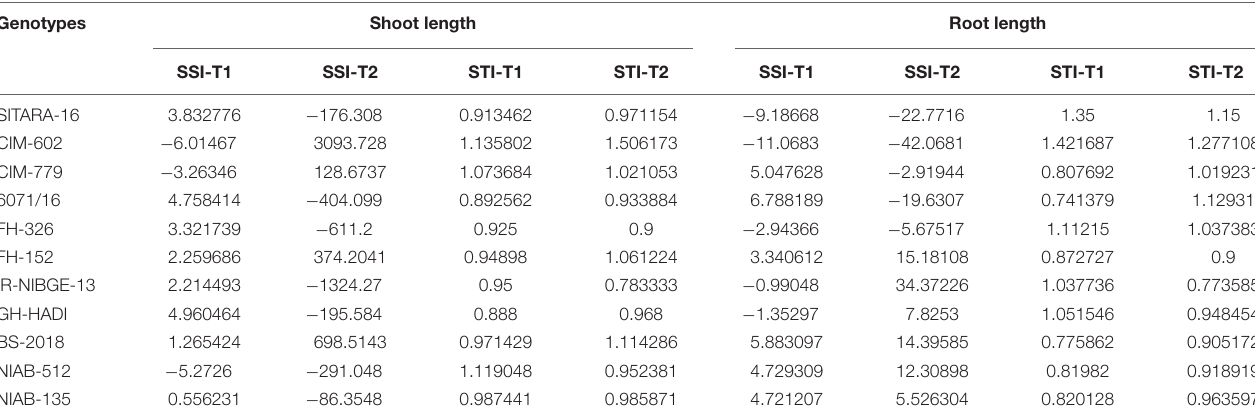
FIGURE 5 | Pictorial view of panels (A) NIAB-512, (B) NIAB-135, and (C) 6071/16 under control and salt stress conditions (sand pot in glass house) at fourth true leave stage. Schematic diagram of recording physiological parameters: Measuring chlorophyll content by using (D) SPAD and stomatal conductance, transpiration, and photosynthetic rate before harvesting by using (E) porometer. TABLE 4 | Stress susceptibility and tolerance indices for shoot and root